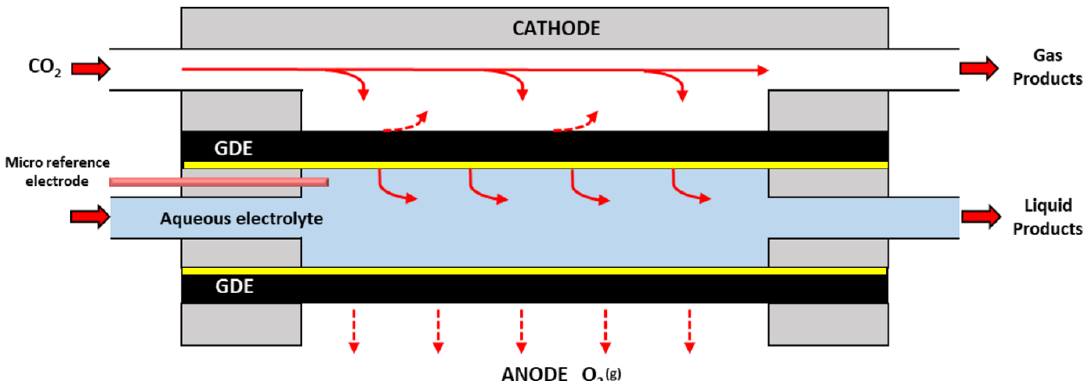
Figure 8. Schematic diagram of a CO 2 microfluidic electrolyser. The cathode and anode are both gas diffusion electrodes with their corresponding catalyst layers are shown in yellow. In this picture, the reactor operates without a membrane. A micro reference electrode can be used to monitor the working electrode potential.